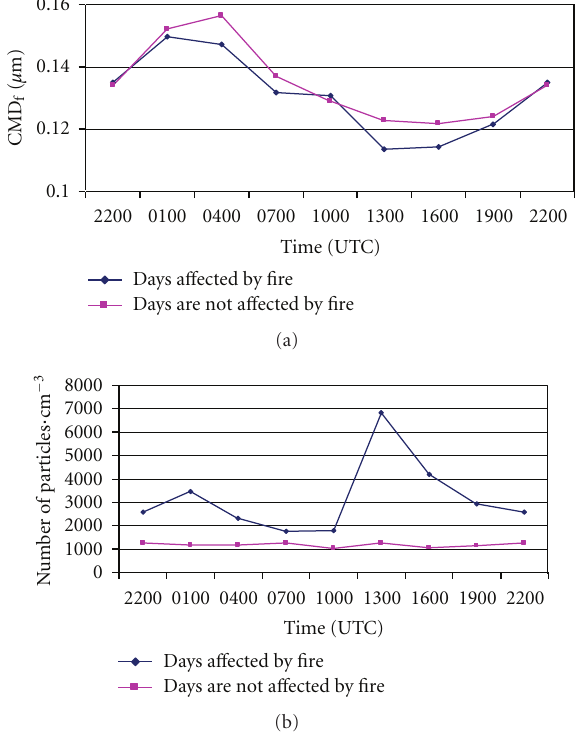
Figure 8: Comparative analysis of the evolution of (a) the geometric mean diameter (CMD f ) and (b) the total number of particles in the fine mode in the 8 daily registers, for data including contaminated and noncontaminated measurements.